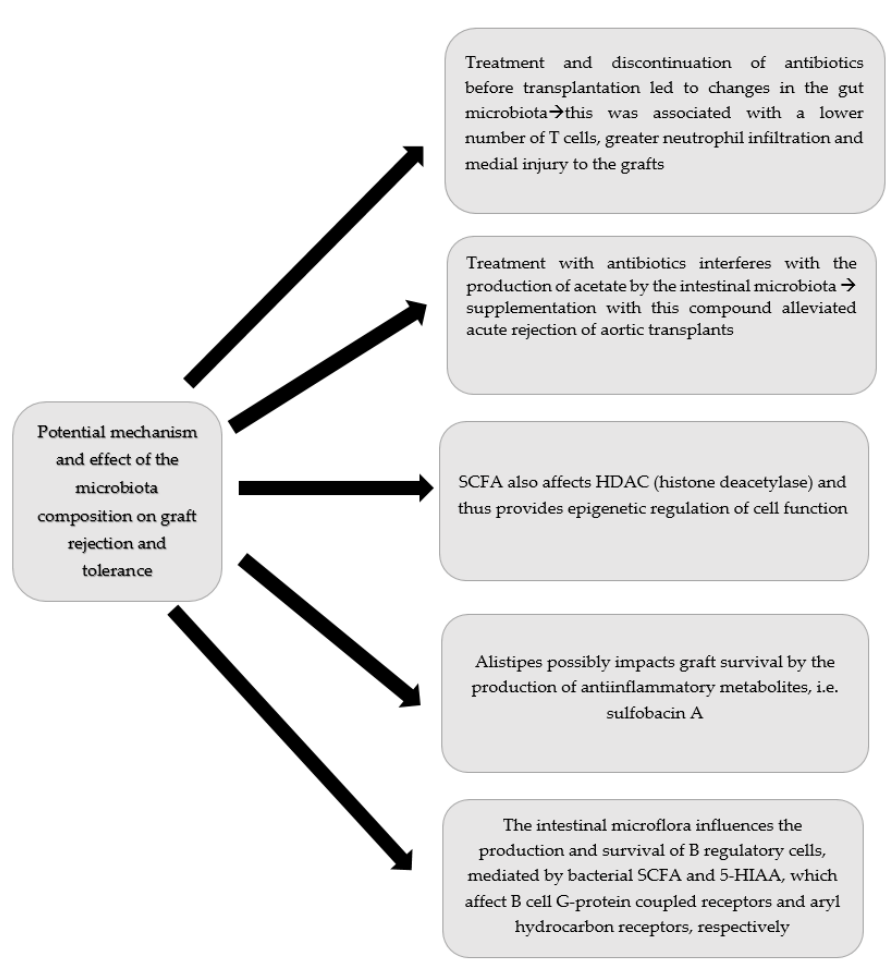
Figure 2. Potential influence of microflora on graft function .